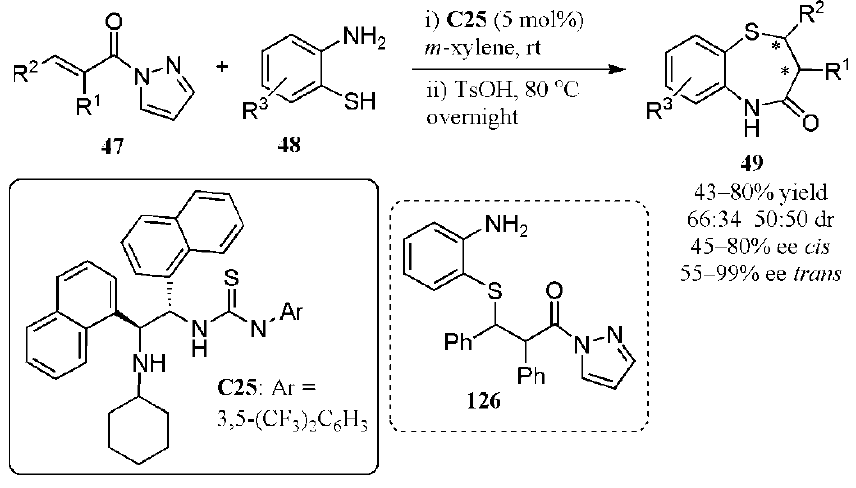
Figure 32. One-pot synthesis of chiral 1,5-benzothiazepines 49 [65].